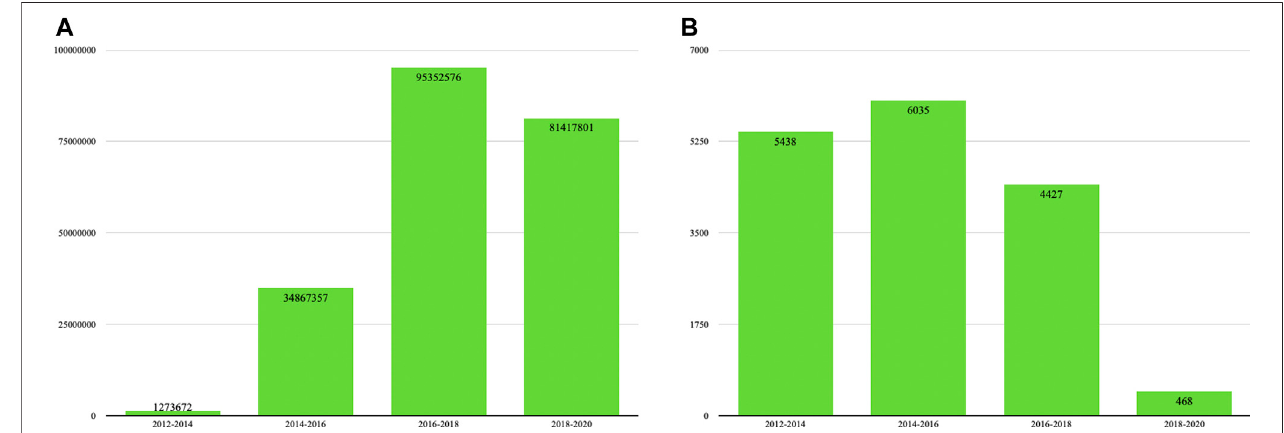
FIGURE 1 | Figure 1 (A) and Figure 1 (B) : Items (posts or page revisions) per bin for our 4chan and Encyclopedia Dramatica datasets, respectively.